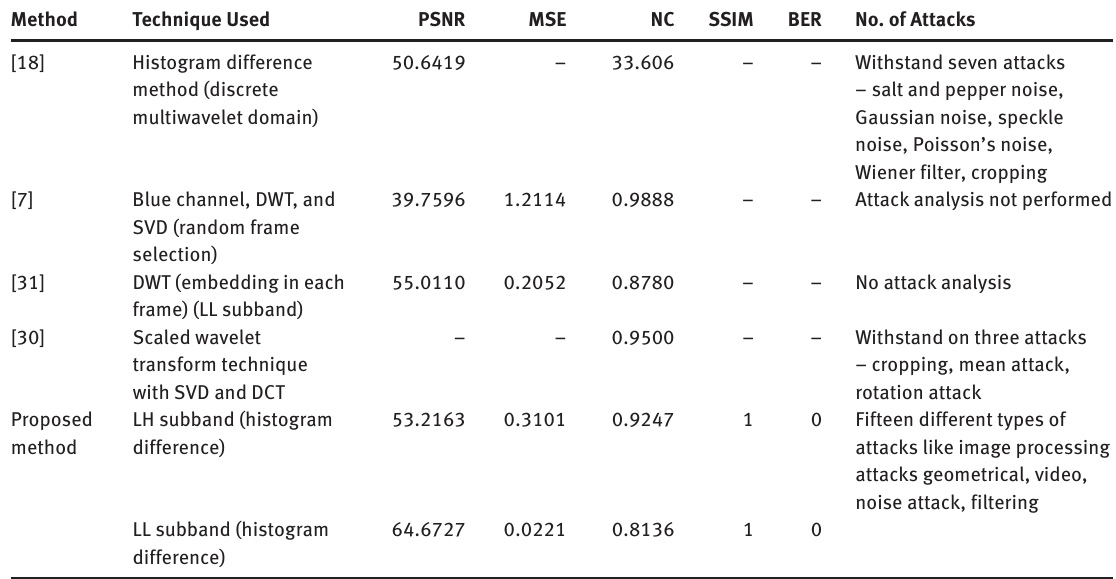
Table 16: Comparative Analysis Based on Parameters.